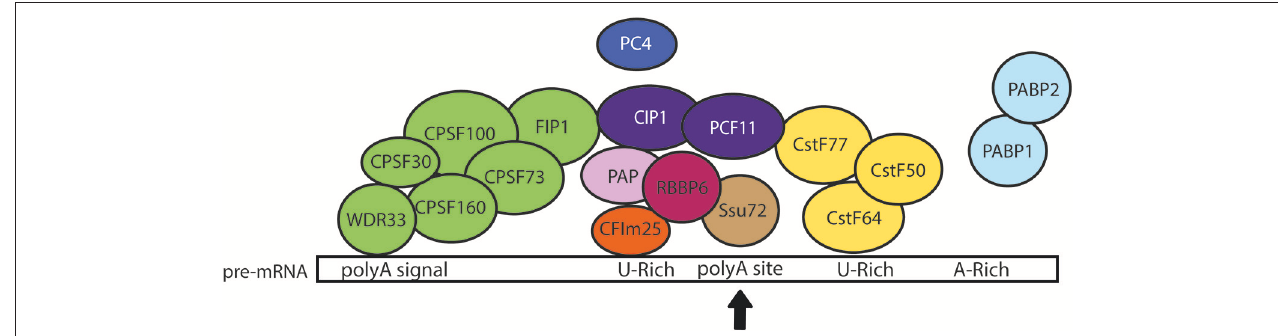
FIGURE 2 | Model of the pre-mRNA 3 ′ processing complex in E. histolytica . The core 3’ processing complex is composed of four main complexes: CPSF (green), CstF (yellow), CFIm (orange), and CFIIm (purple) that bind cis -elements within pre-mRNA 3 ′ UTR. Based on the current knowledge in other eukaryotic cells, we hypothesize that the WDR33 subunit of CPSF complex recognizes the polyadenylation signal (polyA signal) located upstream of the cleavage site (polyA site marked here with a black arrow), while CstF64 recognizes the U-rich downstream element. We also propose that the binding of CFIm25 to the upstream U-rich motif promotes the recruitment of CFIIm subunits (CIP1 and PCF11) and interactions between CPSF and CstF, allowing the RNA cleavage by CPSF73 and the poly(A) tail synthesis by PAP. Additional factors, such as FIP1, PC4, RBBP6, Ssu72, and PABP, would also contribute to the regulation of cleavage/polyadenylation reaction (López-Camarillo et al., 2005). Interactions between EhCFIm25 and EhPAP have been experimentally confirmed in vitro (Pezet-Valdez et al., 2013). Interestingly, the interaction of EhCstF77 with U1-A provided the first evidence for a link between mRNA polyadenylation and splicing in Entamoeba (Valdés et al., 2014).